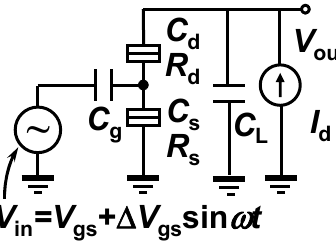
Figure 10. A circuit diagram of the SET-based inverting amplifier with constant-current load and load capacitance C L .